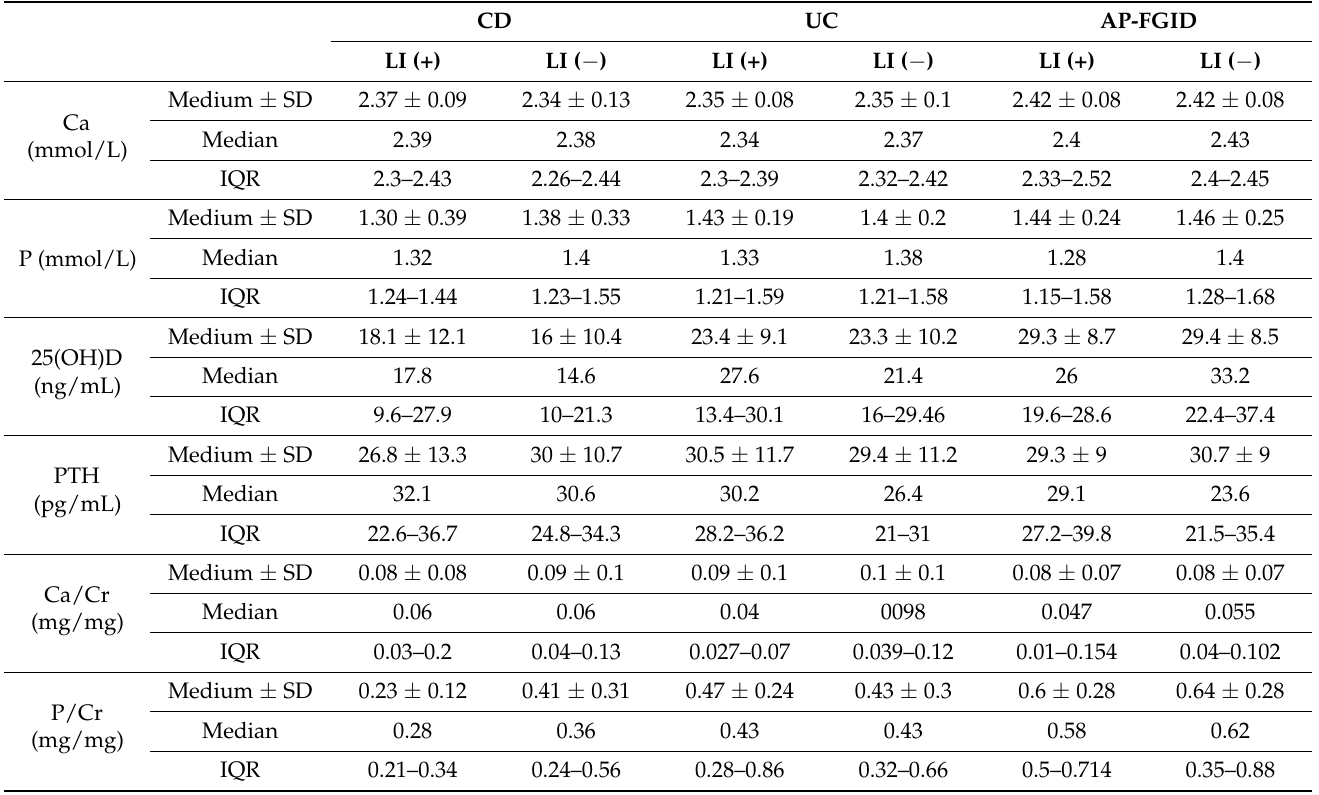
Table 3. Test results of calcium and phosphate metabolism parameters depending on lactose tolerance in the studied